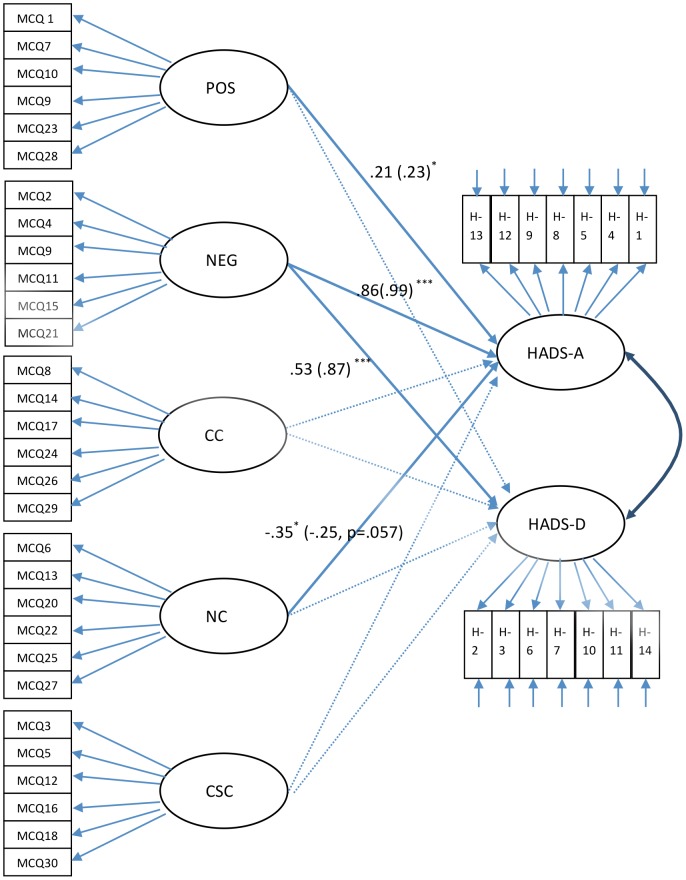
Structural equation model of the relationship between the MCQ-30 and HADS anxiety and HADS depression.N.B. Rectangles indicate observed variables on MCQ-30 (MCQ) or HADS (H); ellipses indicate latent factors. Latent factors: Positive beliefs about worry (POS); Negative beliefs about worry (NEG); Cognitive Confidence (CC); Need to control thoughts (NC); Cognitive Self-consciousness (CSC); HADS Anxiety (HADS-A); HADS Depression (HADS-D). Figures show standardised path coefficients and their significance at pre-treatment and (in brackets) 12-month follow-up. Errors not shown; *** p<.001 ** p<.01 * p<.05